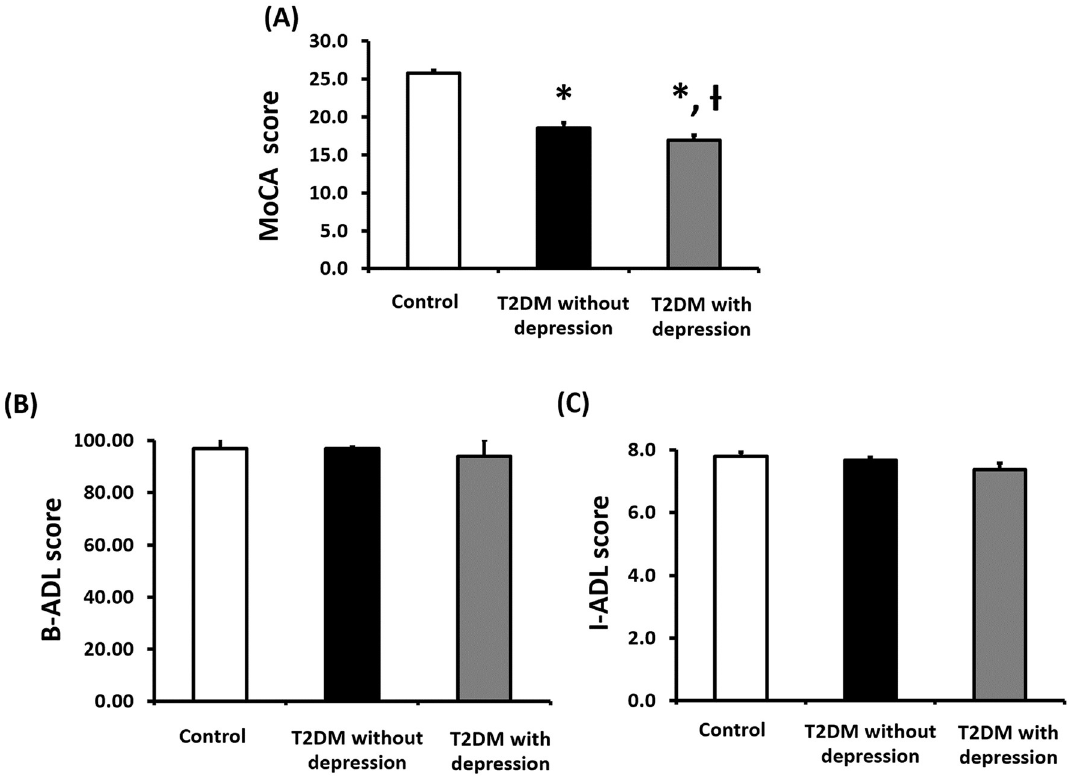
Fig 1. Effects of depression on the cognitive function and the ability to perform ADLs in T2DM patients. Effects of depression on the cognitive function (MoCA score (A)) and ability to perform ADLs (B-ADL score (B) and I-ADL score (C) in T2DM patients. � p < 0.05 vs. control group, † p < 0.05 vs. T2DM without depression group. Abbreviation: MoCA = Montreal cognitive assessment, B-ADL = Basic activities of daily living, I-ADL = Lawton instrumental activities of daily living, T2DM = Type 2